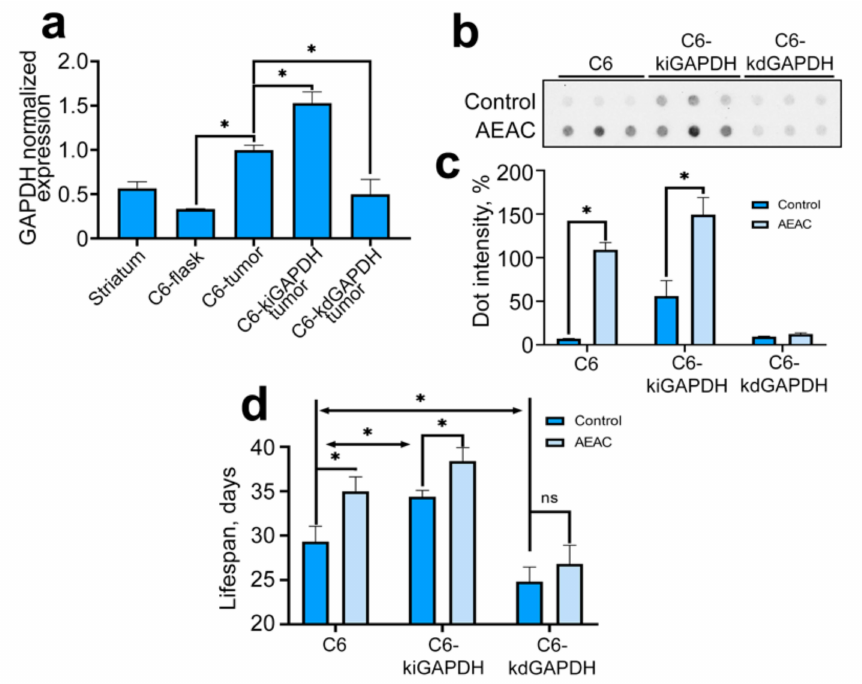
Figure 5. The level of GADPH expression in glioma tumors affects the enzyme aggregation and the lifespan of experimental rats. ( a ) The data of RT-PCR are presented. Histogram bars show the relative amount of mRNA transcribed from the gapdh gene in C6 cells cultivated in flasks and injected in rat brain normalized to the amount of actin mRNA. ( b ) Tumors formed in rats (treated or non-treated) from C6 cells with different GAPDH level were lysed and subjected to dot ultrafiltration. The resulting membrane was probed with antibody against GAPDH. Each dot illustrates the result for one rat’s tumor. ( c ) The average calculated dot intensity is presented. ( d ) The histogram bars illustrate the lifespan of rats after C6 cell injection. Data presented as mean ± standard error of mean (SEM). Statistical significance is indicated as * p <